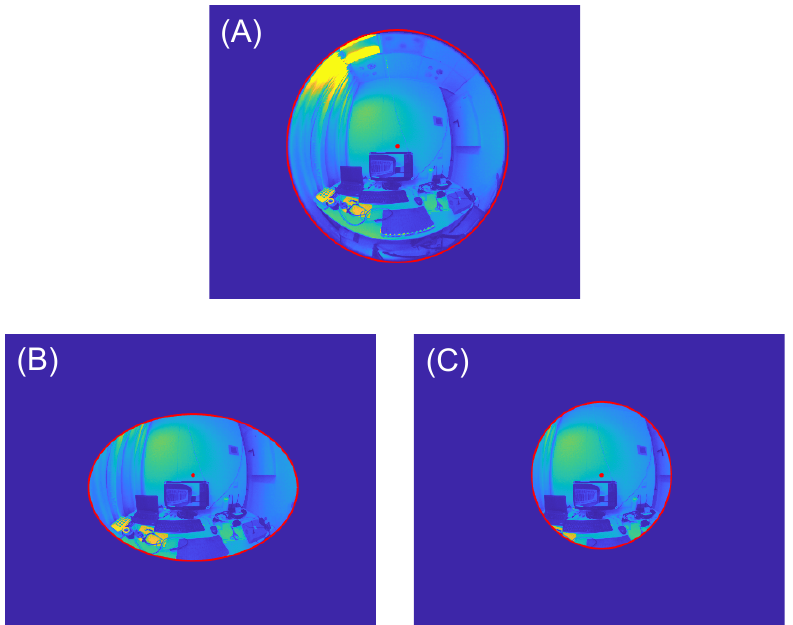
Figure 5. Masking possibilities for the CS LMK calculation considered in this work. ( A ) Half-space geometry; ( B ) field of view definition of CIE S 026:2018 [15]; ( C ) field of view of an assumed 120°